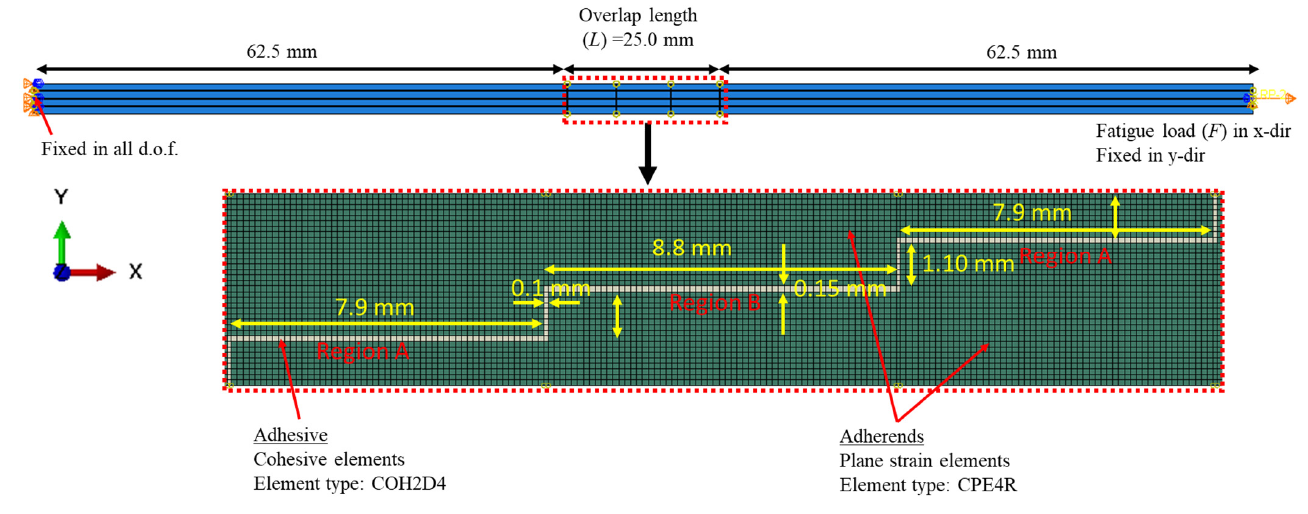
Figure 1. An FE model of an adhesively bonded three ‐ step ‐ lap joint under cyclic tensile loading. The left ‐ end side of the step ‐ lap joint was fixed in all degrees of freedom. A kinematic coupling was defined on the opposite side, where the centre point was controlling this end surface. It was free to move only in the x ‐ direction, where the tensile load was applied from this centre point. In the simulations, 9.0, 8.0, and 7.0 kN cycling load F values were used.